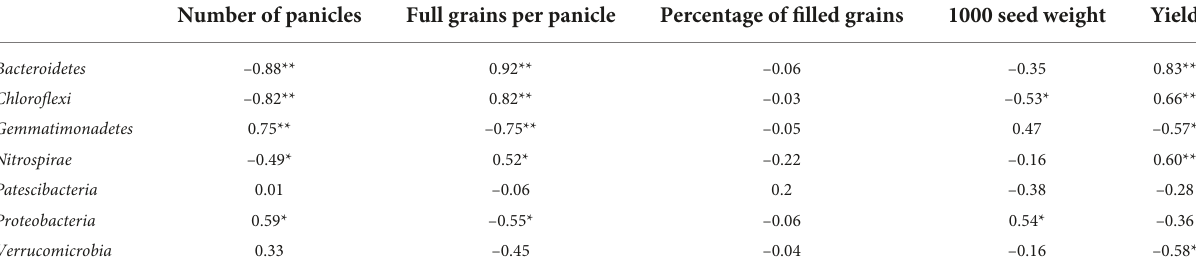
TABLE 6 Pearson’s correlation coefficients between abundant phyla and grain yield and